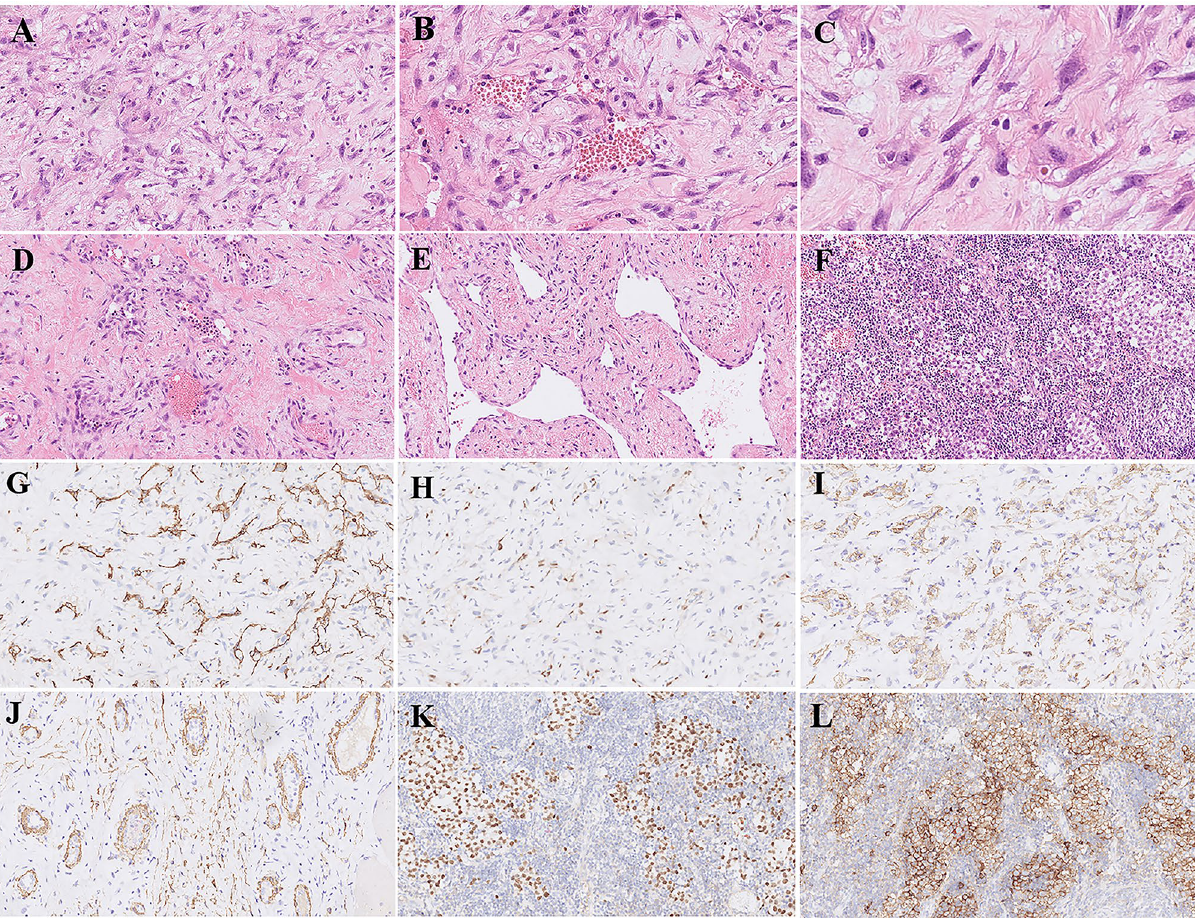
Fig. 2 Microscopic morphology and immunohistochemical characteristics of the tumour. (A) Spindle to stellate cells in a myxoid stroma. (B) Atypical cells form cleft-like spaces in which erythrocyte clusters can be seen. (C) Mitosis and individual erythrocytes within intracytoplasmic lumens. (D) Thin-walled blood vessels were formed. (E) Plexuses of vessels were anastomosed with a collagenized stroma. (F) Atypical seminoma cell clusters with clear cytoplasm were seen in the lymphoid stroma. (G) Spindle cells lining along clefts in myxoid stroma were positive for CD34. (H) ERG was expressed in endothelial cells. (I) The stellate cells around the clefts expressed SMA, while the lining cells were negative. (J) SMA expression was observed around the thin-walled small blood vessels, whereas the endothelial cells were negative. K) SALL4 was positive in the seminoma. L) PLAP was positive in the